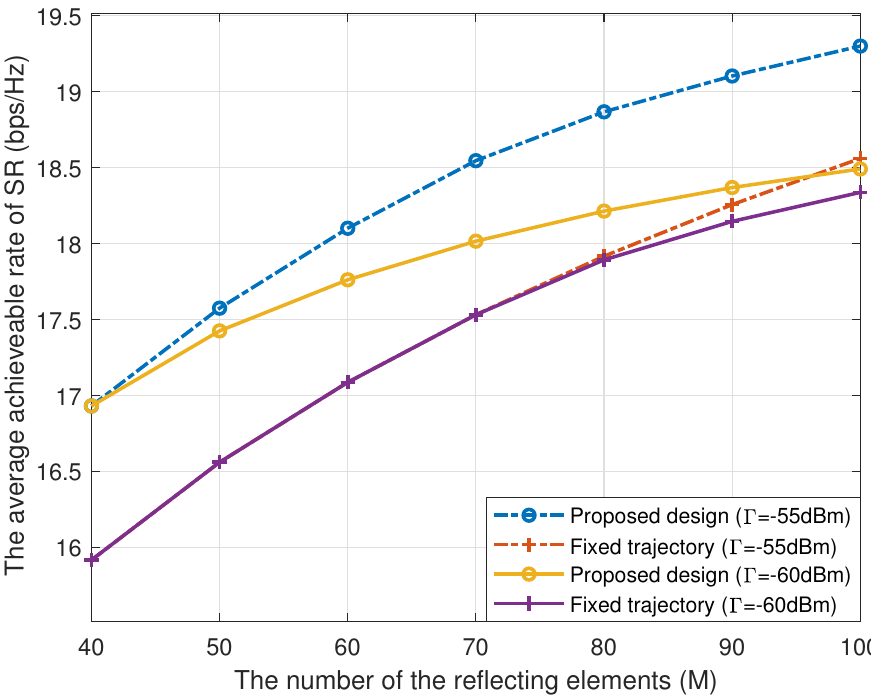
Figure 7. The average achievable rate versus the number of the reflecting